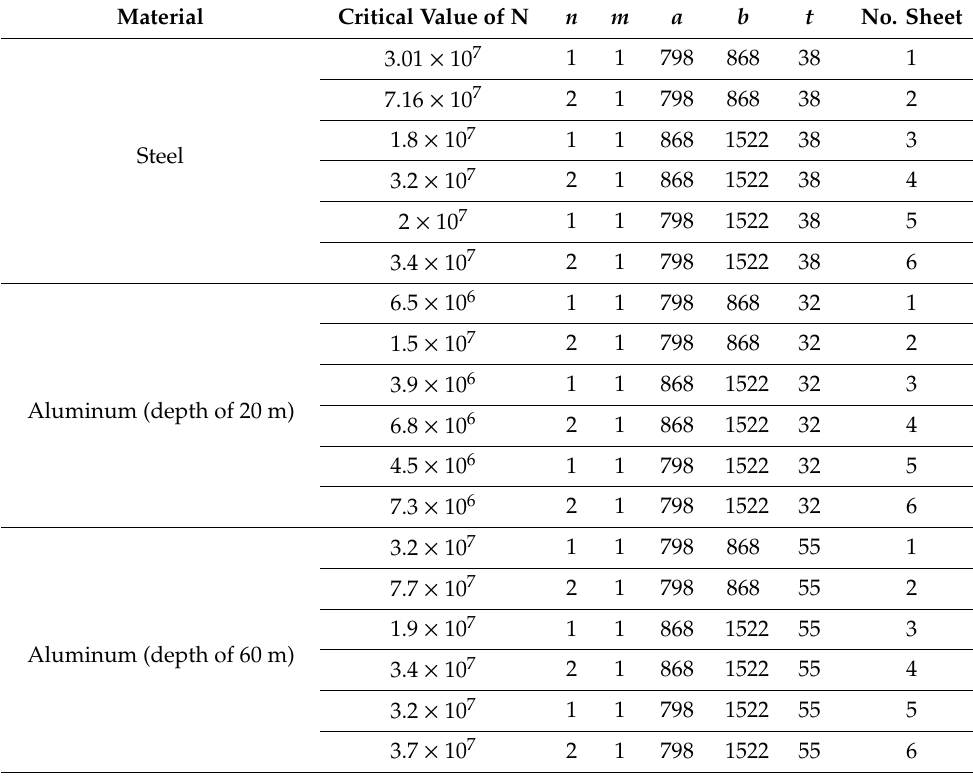
Table 4. Buckling results obtained using the analytical